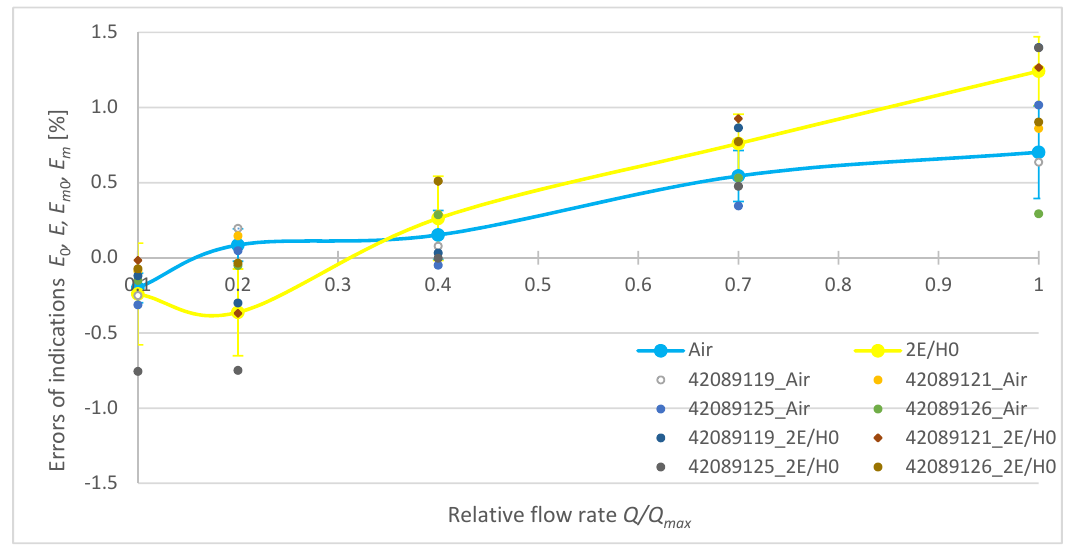
-1.0-0.50.00.51.01.5 -1.5 Figure 6. The errors of indications ( E 0 , E ), the average errors of indications ( E m 0 , E m ) with the confidence interval ( u ) of thermal gas meters for air and natural gas without hydrogen addition as a function of the relative flow rate ( Q/Q max ). -11.0-9.0-7.0-5.0-3.0-1.01.03.0 Figure 7. Average initial errors of indications ( E m 0 ) and average errors of indications ( E m ) along with the confidence interval ( u ) of thermal gas meters for various gas mixtures as a function of the relative flow rate ( Q/Q max ). Figure 8. Average drift of the errors of indications ( E m ) together with the confidence interval ( u ) of thermal gas meters for different gas mixtures as a function of the relative flow rate ( Q/Q max ). Initial errors of indications ( E 0 ), errors of indications ( E ), average initial errors of indications ( E m 0 ) and average errors of indications ( E m ) together with the confidence interval ( u ) of thermal gas meters (serial numbers 42089119, 42089121, 42089125 and 42089126) adjudged at the ambient and gas temperature of − 25 °C and 55 °C, respectively, are shown in Table 4, Figure 8 and Figure 9. The errors of indications were determined with the use of air for individual test variants given in Table 2. The uncertainty of the measurements while assessing the errors of indications is ±0.20 ÷ 0.50% in the range of flow rates from 0.1 Q max to Q max .